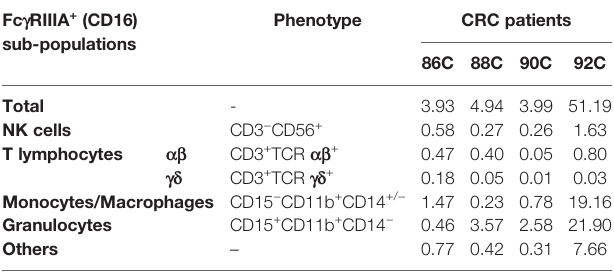
TABLE 2 | Nature and percentages of Fc g RIIIA + (CD16) tumor-in fi ltrating cells among all viable cells (immune and tumor cells). Fc g RIIIA + (CD16)